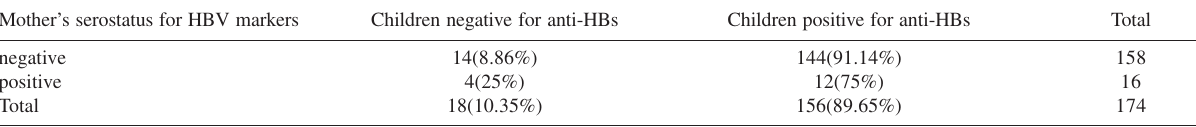
Table 5 - Age at the third HBV vaccine dose versus seroconversion, by stratification into 2 age groups Mother’s serostatus for HBV markers